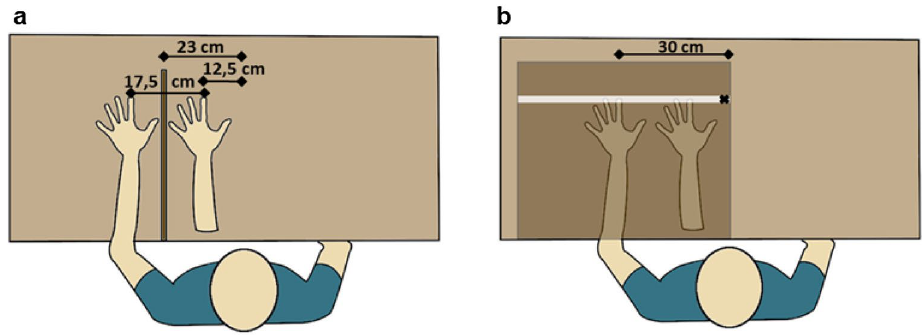
Figure 7. Illustration of the experimental setup. ( a) RHI stimulation setup. ( b) Proprioception measure, applied using a wooden box with a tape